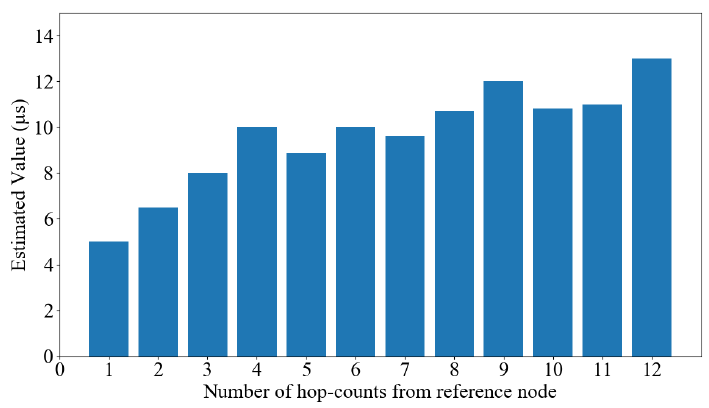
Figure 5. Average estimatedDelay value of nodes at same hop distance to the reference node.